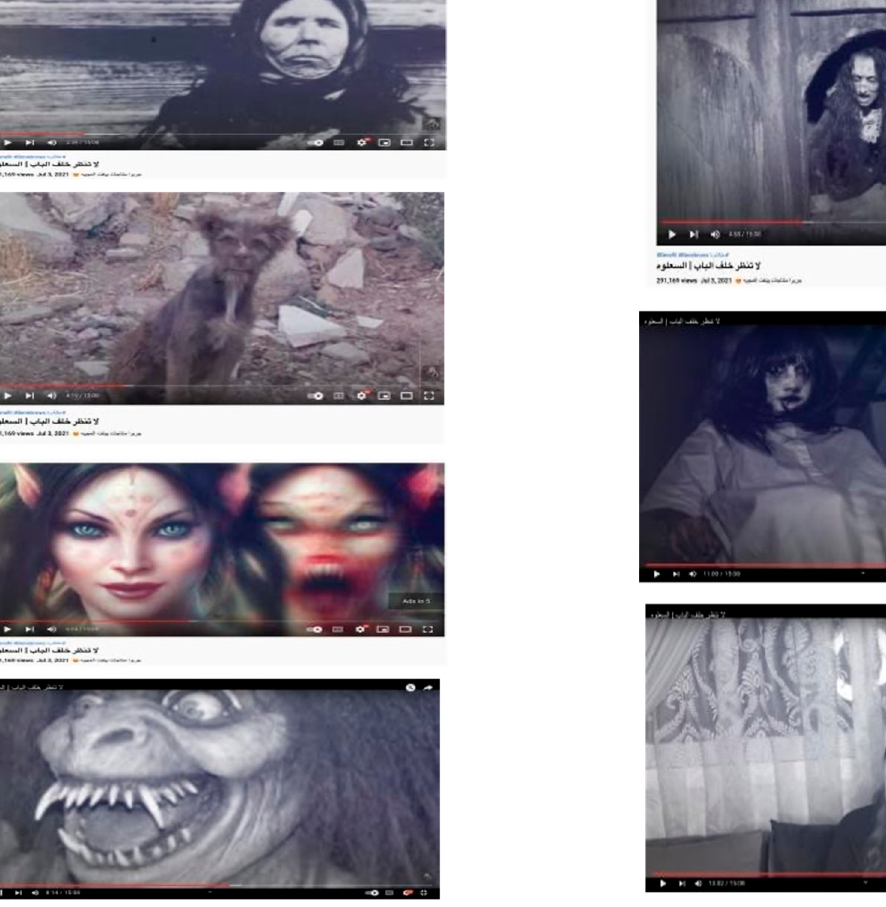
Figure 1. Screengrabbed with permission from @Ranoy7’s (2021) episode Don’t Peek Behind the Door: The Sa’lawwa